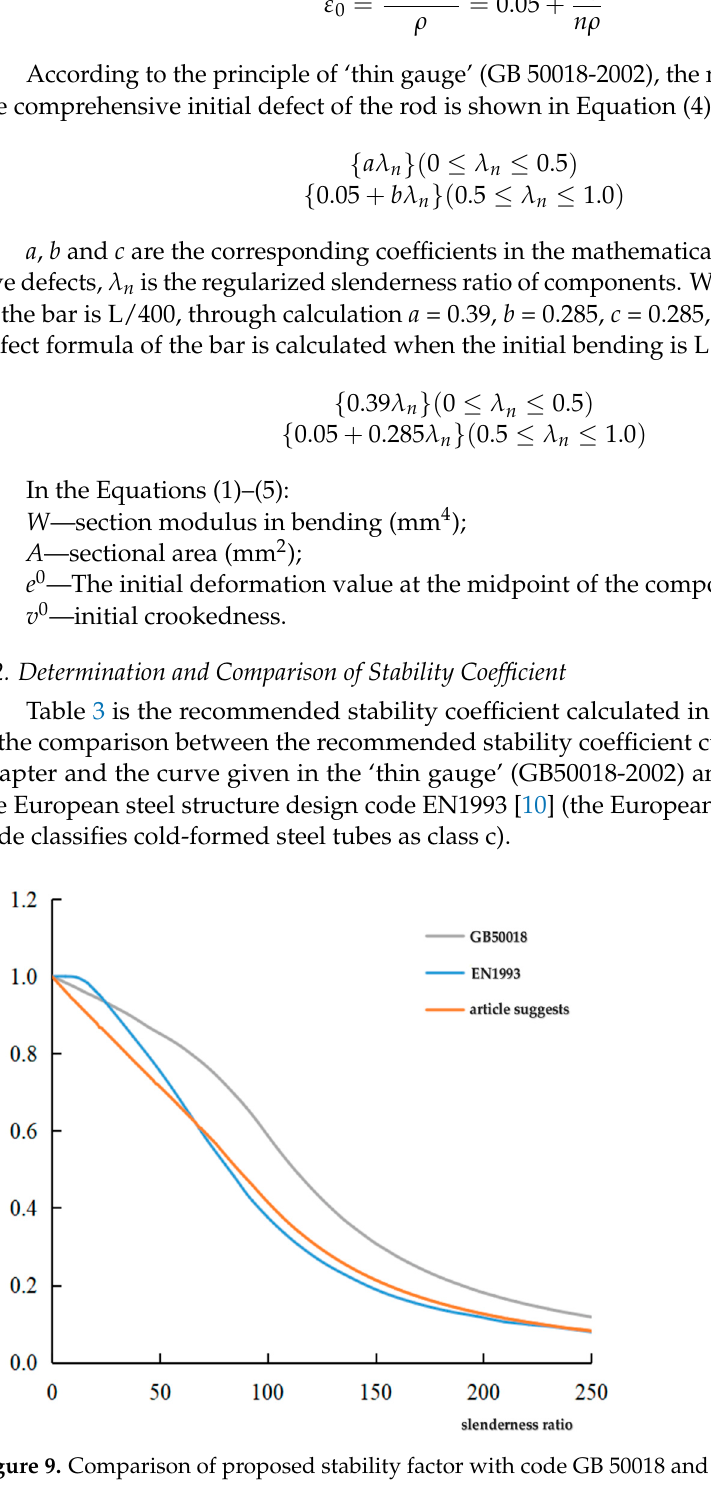
Table 3. Stability factor of fastener-type steel pipe support.